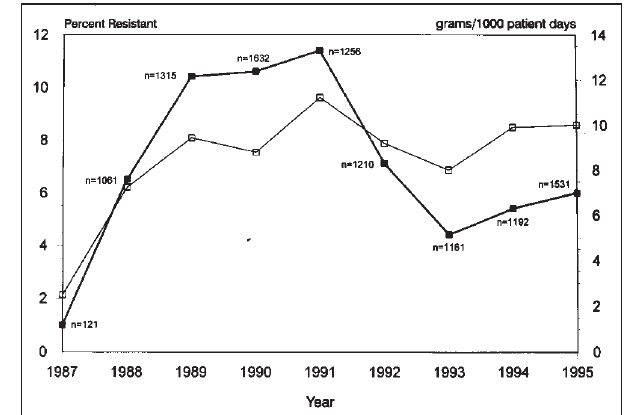
Figure2) Relationshipbetweenimipenemuse(gramsper1000patient days), and the prevalence of imipenem-resistant Pseudomonas aeruginosa from 1987 too 1995. The number of isloates tested in each year is